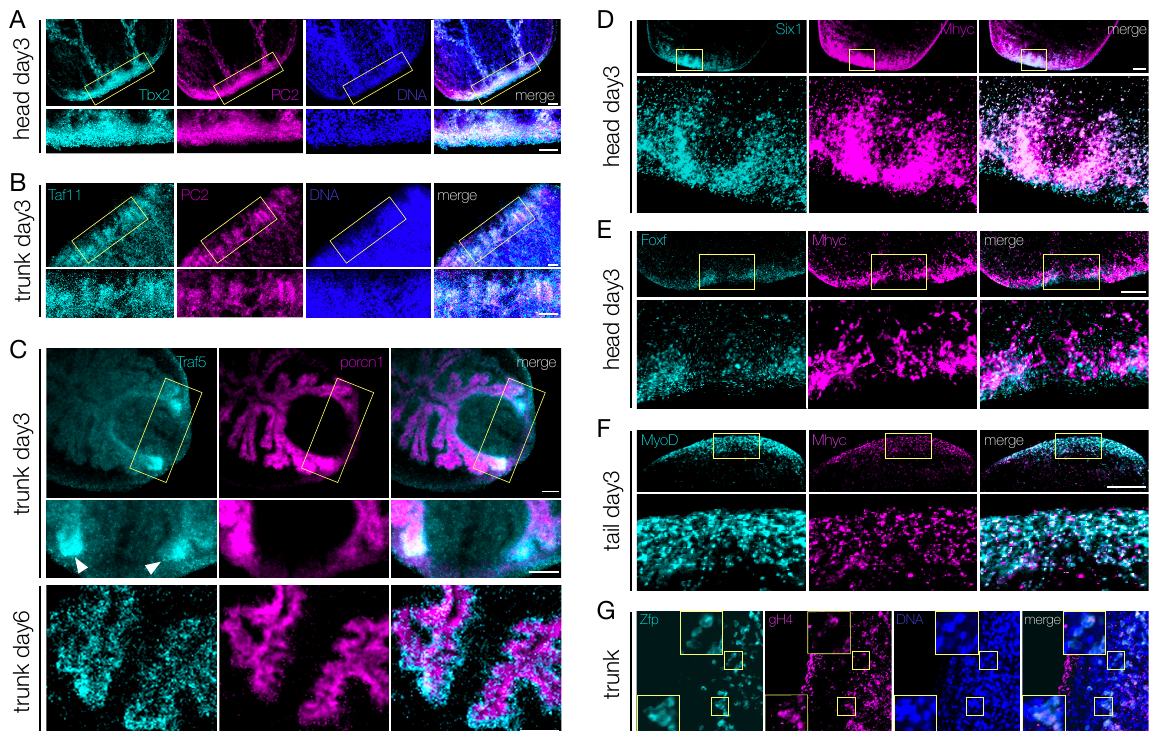
Figure 7. Co-localization of the transcripts of the shortlisted TFs with those of tissue-specific markers. ( A , B ) Co-localization of Tbx2/3 ( A ) and Taf11 ( B ) mRNAs with the pan-neuronal marker PC2 (as for double-WISH) in day 3 blastema of regenerating head fragments. The areas in the upper panels surrounded with the yellow frames are enlarged in the respective lower panels. Scale bars: 50 µ m. ( C ) Traf5 expressing cells are located around the gut linen, which is marked by porcupine (as for double-WISH), both at day 3 (upper and middle panels) and at day 6 (lower panel) of regeneration. Traf5 signal is stronger in the newly formed tissue close to the wound, especially in the early phase of regeneration (white arrowheads). The yellow frames in the upper panel show the regions enlarged in the middle panel. Scale bars: 50 µ m. ( D – F ) Co-localizion of Six-1 ( D ), FoxF ( E ), or MyoD ( F ) mRNAs with Myhc mRNA (as for double-WISH) in blastema at day 3 of regeneration. The areas in the upper panels surrounded with the yellow frames are enlarged in the respective lower panels. Scale bars: 50 µ m. ( G ) Cells co-expressing Zfp mRNA with the germinal histone 4 mRNA, in the trunk fragment of planarians at day 6 of regeneration. Either double-positive or double-negative cells are visible. The inserts show an enlargement of the areas surrounded by the yellow frames. Scale bars: 50 µ m.